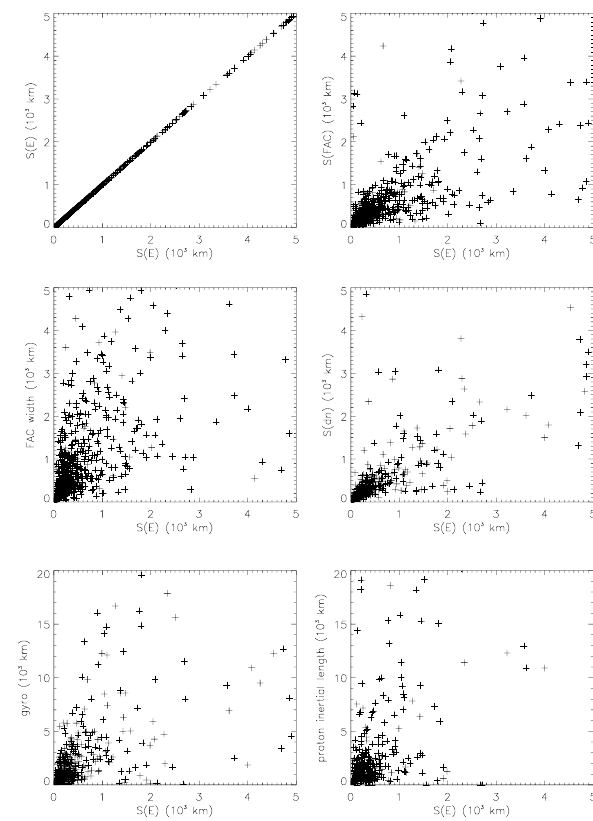
Fig. 3. Overview of all events in the form of scatter plots. The parameters plotted are S(E) , S( FAC ) , FAC width, S(dn) , proton gyroradii and proton inertial length, all vs. S(E) . These values are mapped to the ionosphere.